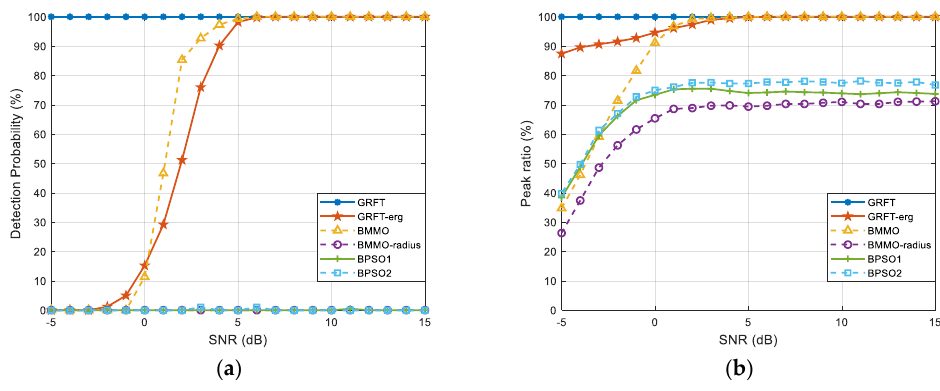
Figure 6. Multi-target detection results: ( a ) detection probability and ( b ) peak ratio.